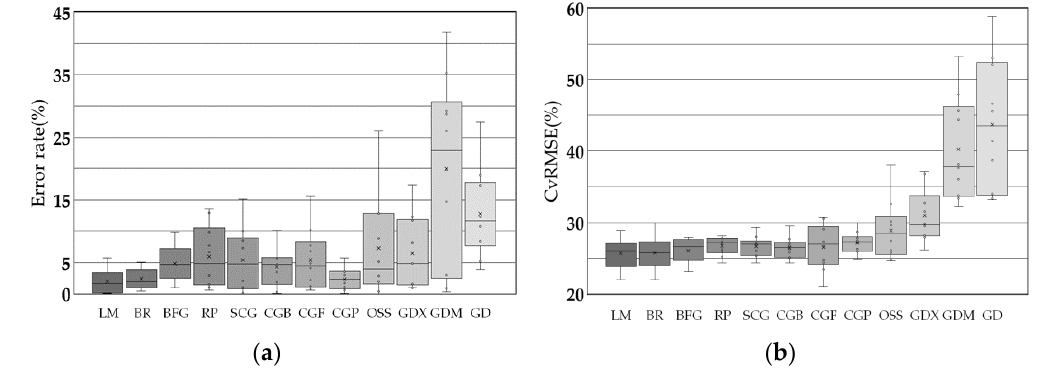
Figure 5. Prediction results: ( a ) error rate and ( b ) CvRMSE distribution. Table 3. Minimum, maximum, and standard deviation (SD) of error rate and CvRMSE by multilayer shallow neural network training algorithms.